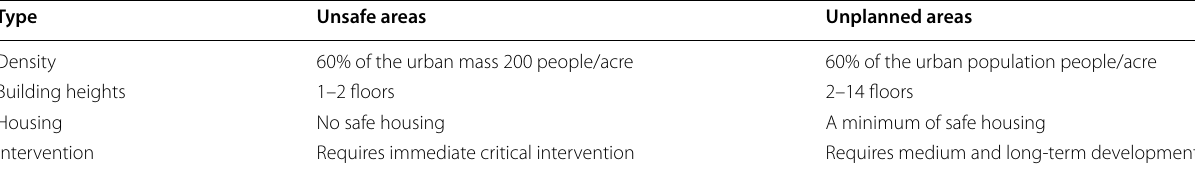
Table 2 Types of slums in Egypt (according to Central Agency for Public Mobilization and Statistics agency 2020)